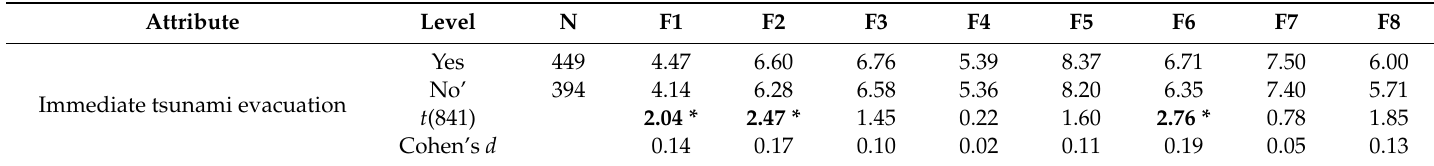
Table 2. External validity of short-form Power to Live with Disasters scores with respect to tsunami evacuation. The t -values indicate statistical di ff erences in scores